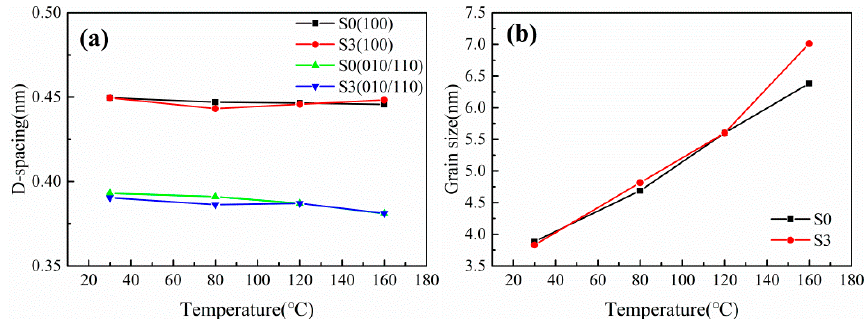
Figure 7. The ( a ) d-spacing and ( b ) grain size of uniaxially stretched PA612 and PA612/SiO 2 films ( ε = 1.5) at different stretching temperature.